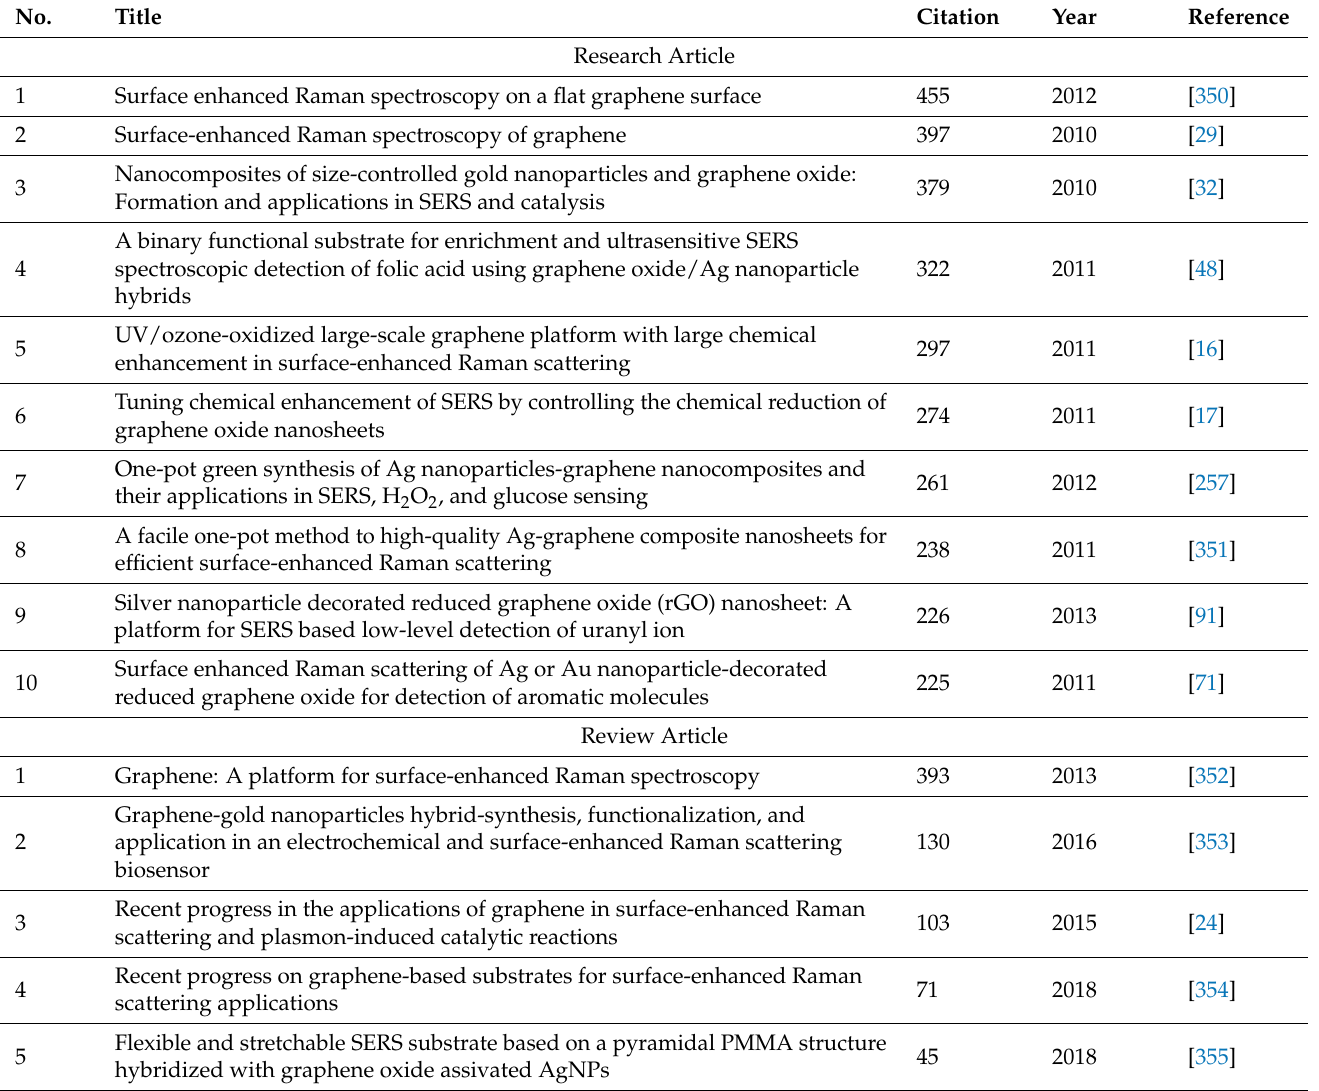
Table 7. The top 10 highly cited research papers and top 5 highly cited reviews in the field of graphene-based